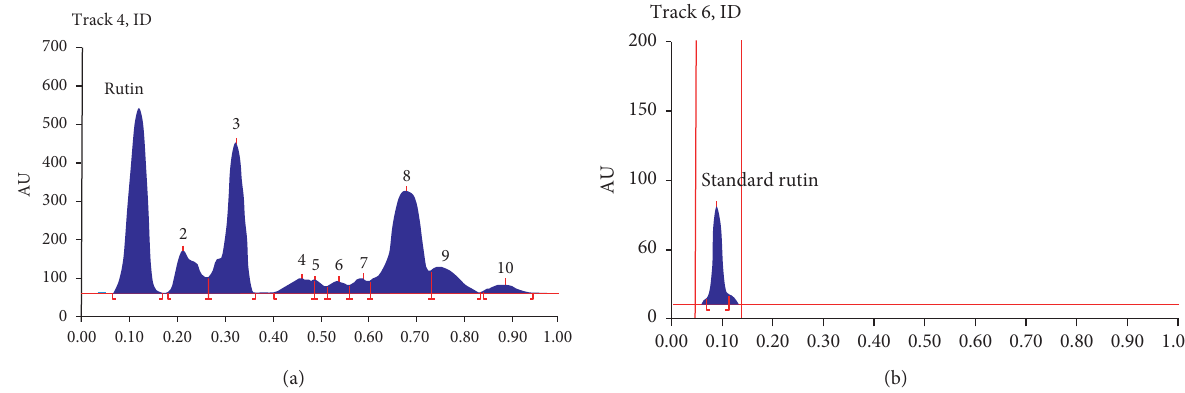
Figure 6: HPTLC analysis of the ethyl acetate fraction of Bauhinia rufescens on a silica gel plate, developed in toluene:ethyl acetate:formic acid (5:4:1, v/v/v), showing number of compounds and rutin as the standard.